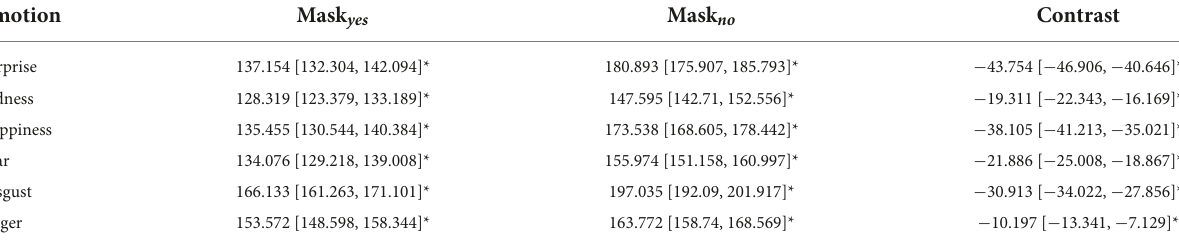
TABLE 3 Posterior distribution summaries for the perceived intensity Mask effect as a function of the displayed Emotion.